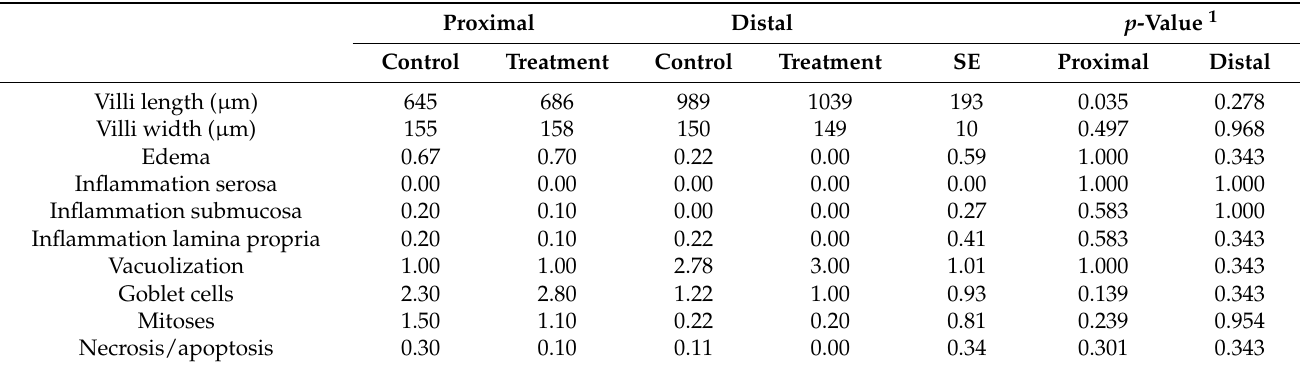
Table 2. Histology of the proximal and distal intestine of rainbow trout ( n = 9) after feeding the control and treatment diets for four weeks.